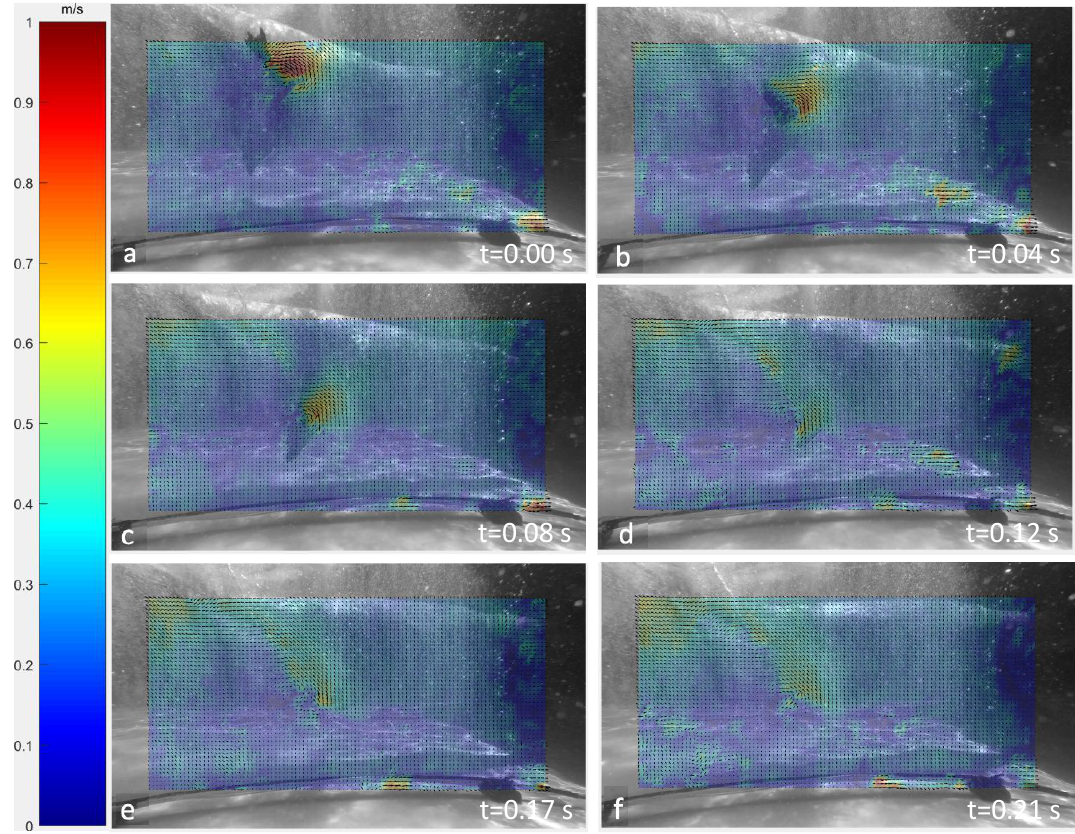
Figure 5. The velocity fields measured with bubble PIV of a swimming sea lion were plotted at 6 instances in time as the sea lion completed a propulsive stroke in the plane of the bubble sheet: ( a ) as the animal enters the sheet, ( b – d ) while the propulsive stroke is actively being completed, and ( e,f ) while the sea lion glides through the measurement plane. Images show raw data (underlay) with velocity magnitude (colormap) and velocity vectors.